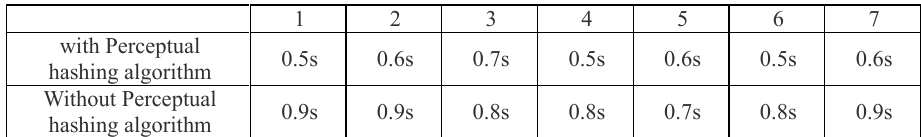
Table 1. Search time comparison.